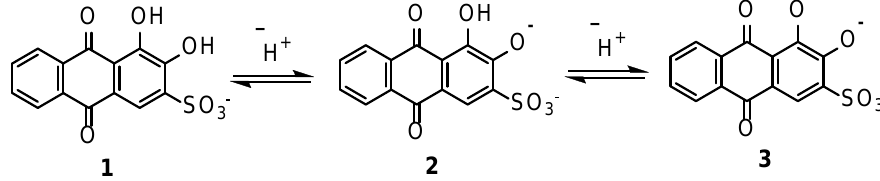
Figure 1. Chemical structure of Alizarin Red S ( 1 ) and its ionized structures ( 2 and 3 ).